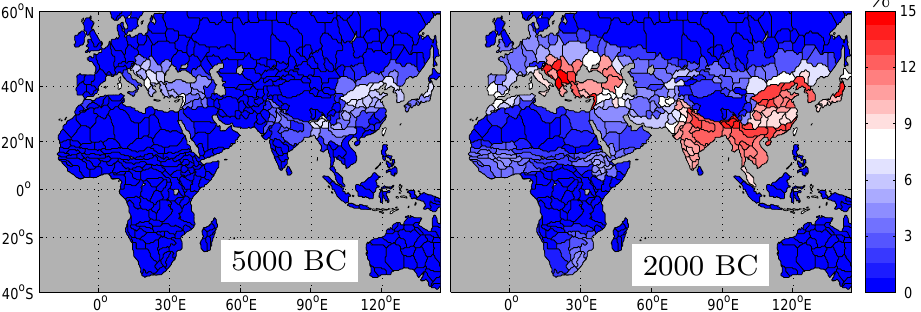
Fig. 3. Fractional crop cover at 5000BC (left) and 2000BC (right) simulated by the Global Land use and Technological Evolution Simulator (GLUES, Lemmen,